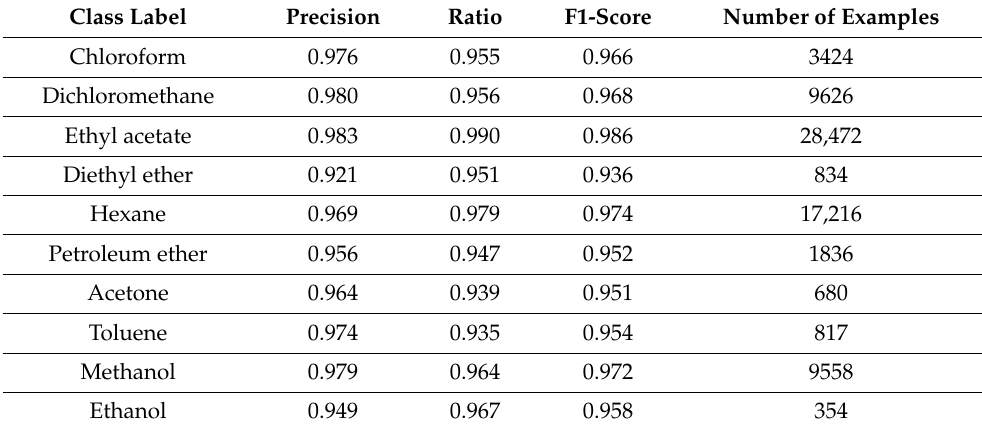
Table 7. Results for separate classes with the best performing method ECFP + E